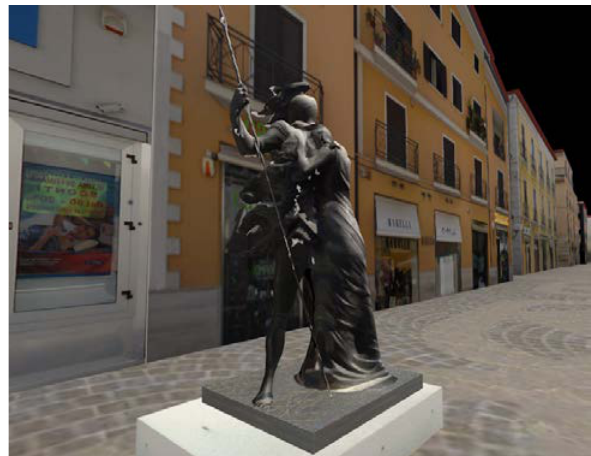
Figure 17. The model of Hector and Andromache in the present